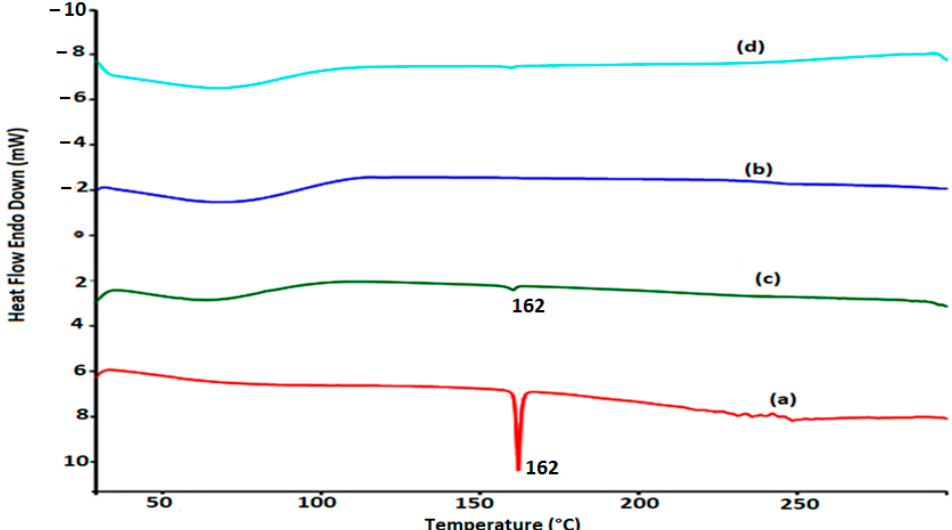
Figure 4. DSC thermograms of FLB (a), HP-BCD (b), physical mixture (c), complex (d).